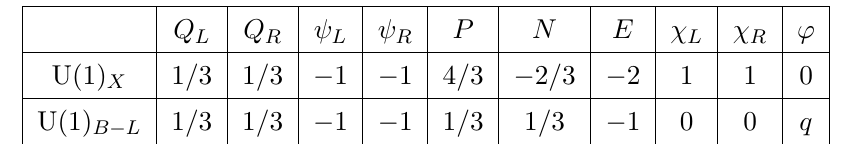
Table 3. Charge assignment for fermions and scalars under U(1) X and U(1) B − L .